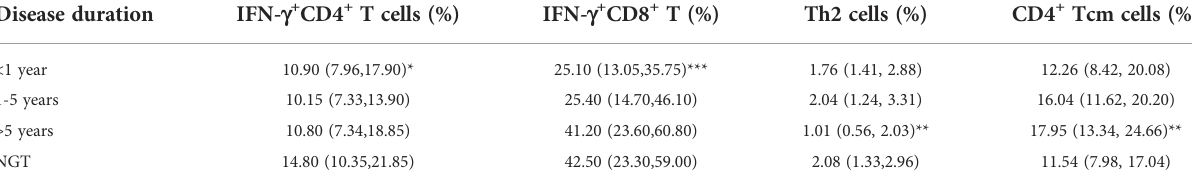
TABLE 5 T-cell subset frequencies in autoimmune diabetic patients with different disease durations. Disease duration